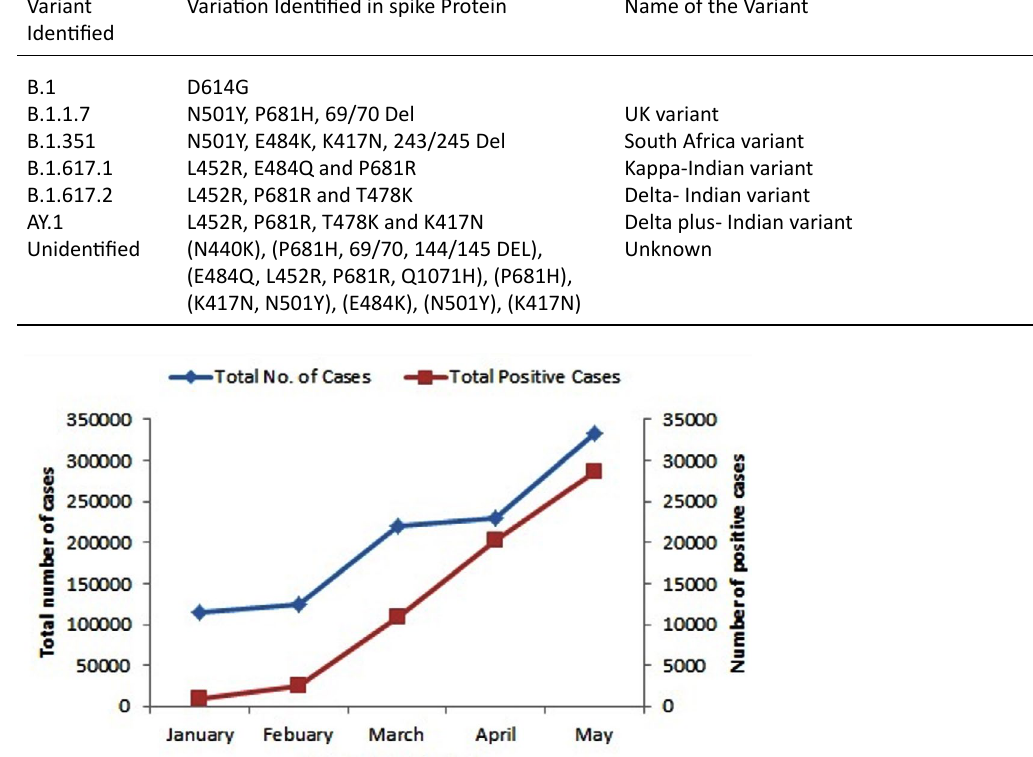
table 1. Different Variants of SARS-CoV-2 and their mutations in the spike protein Variant